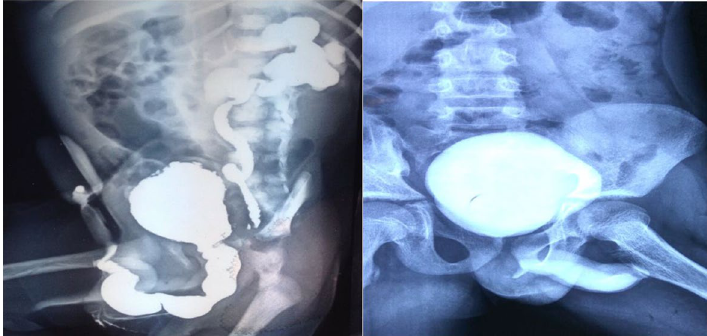
Fig. 2 MCUG. a Case 4 with AUV and PUV with dilated posterior urethra and left-sided VUR. b Case 5 with diffuse diverticular formation of the anterior urethra